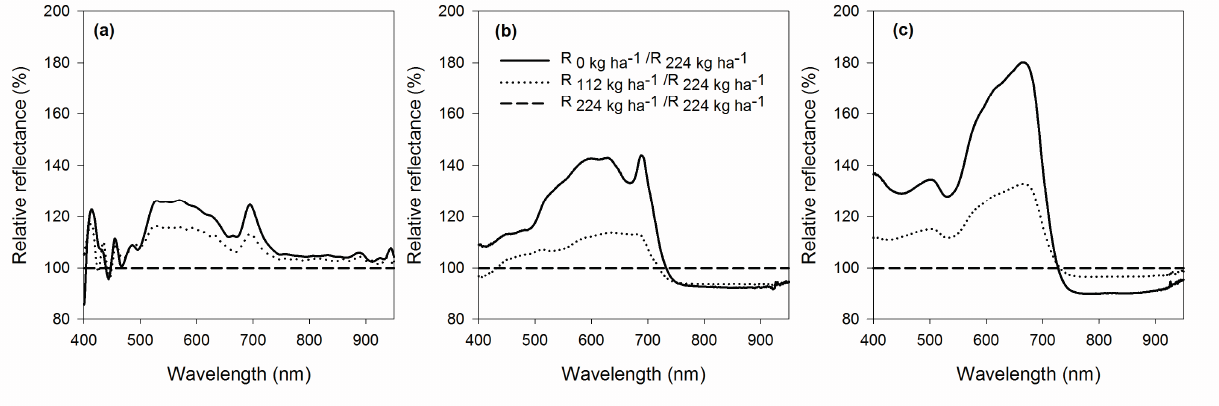
Figure 1. N treatment effects at different spatial scales ( a ) leaf, ( b ) canopy, and ( c )